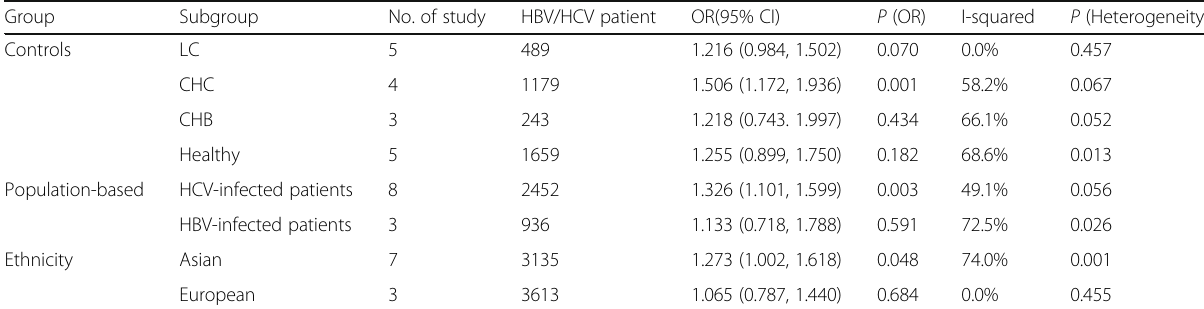
Table 4 Subgroup analysis results under recessive model